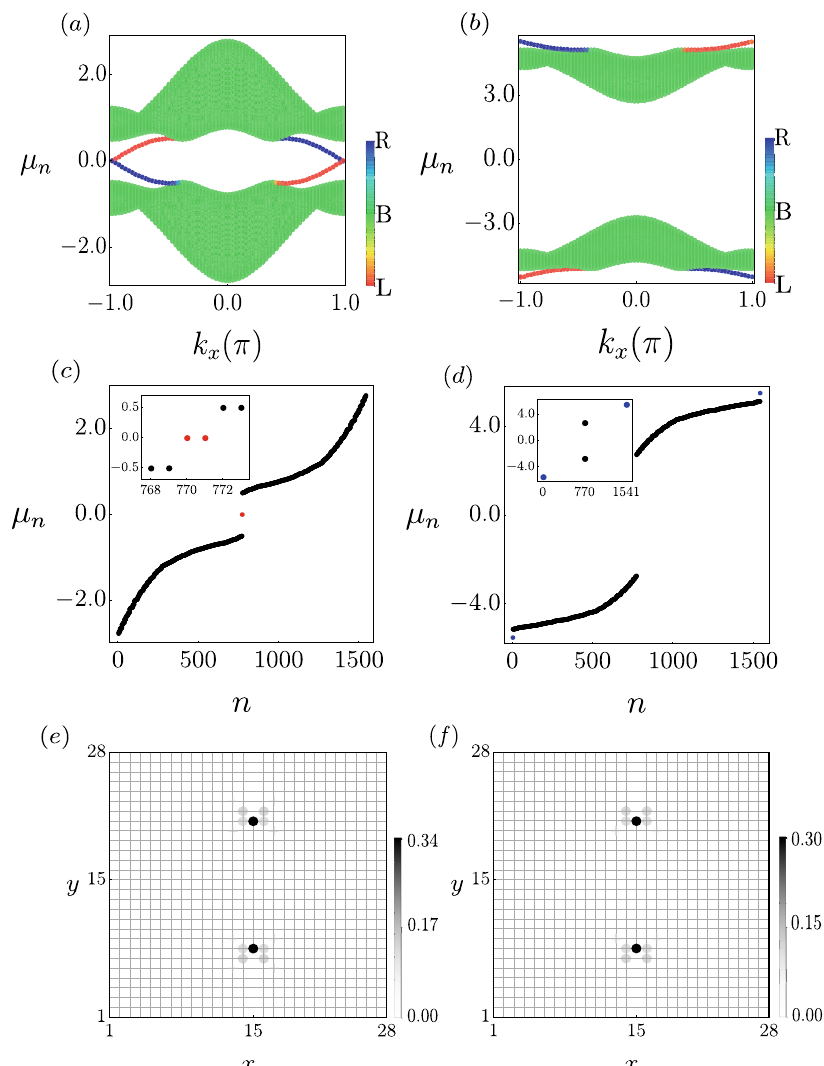
Fig. 3 Translationally active Floquet insulators in the high-frequency regime. Quasienergy ( μ n ) spectra in a semi-in fi nite system of linear dimension L = 100 in the y direction for a drive frequency ω = 12.9 and amplitude m 1 = − 1.84, yielding Chern number C = + 1, and b ω = 11.0, m 1 = − 5.3, yielding C = − 1. Blue and red [green] states are, respectively, localized on the right (R) and left (L) edges [in the bulk (B)], con fi rming that Floquet-Bloch band inversion occurs at k x = π at the Floquet zone center in a and zone boundary in b . c Normal (red) and d anomalous (blue) dislocation modes at quasienergies μ = 0 and± ω /2, respectively, well separated from bulk states (black), in a periodic system with a dislocation-antidislocation pair with Burgers vectors b = ± a e x . Local density of states for e normal and f anomalous dislocation